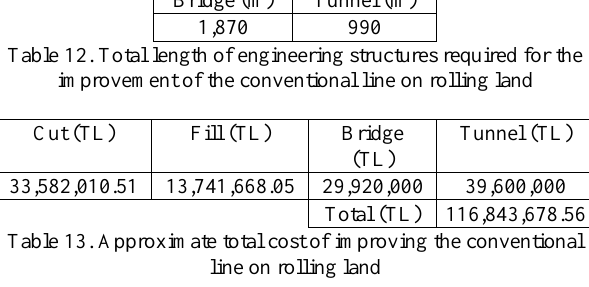
Table 8. Volume of earthworks required for the construction of